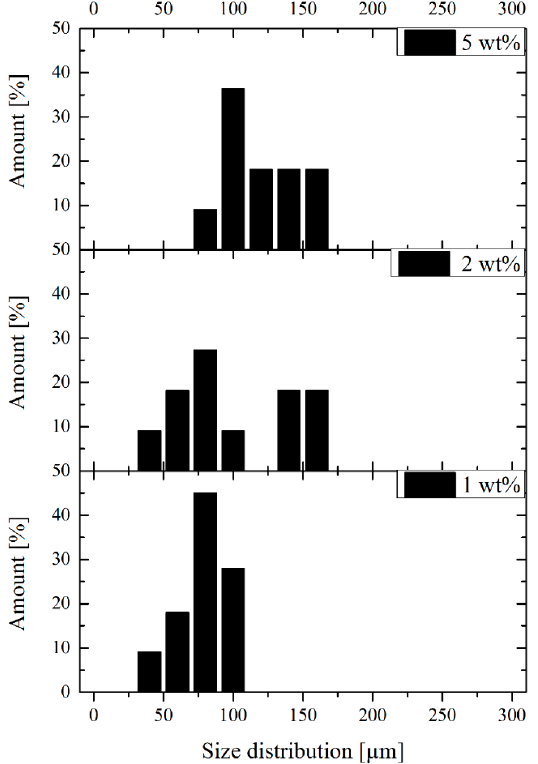
Figure 7. Influence of filler content on size distribution